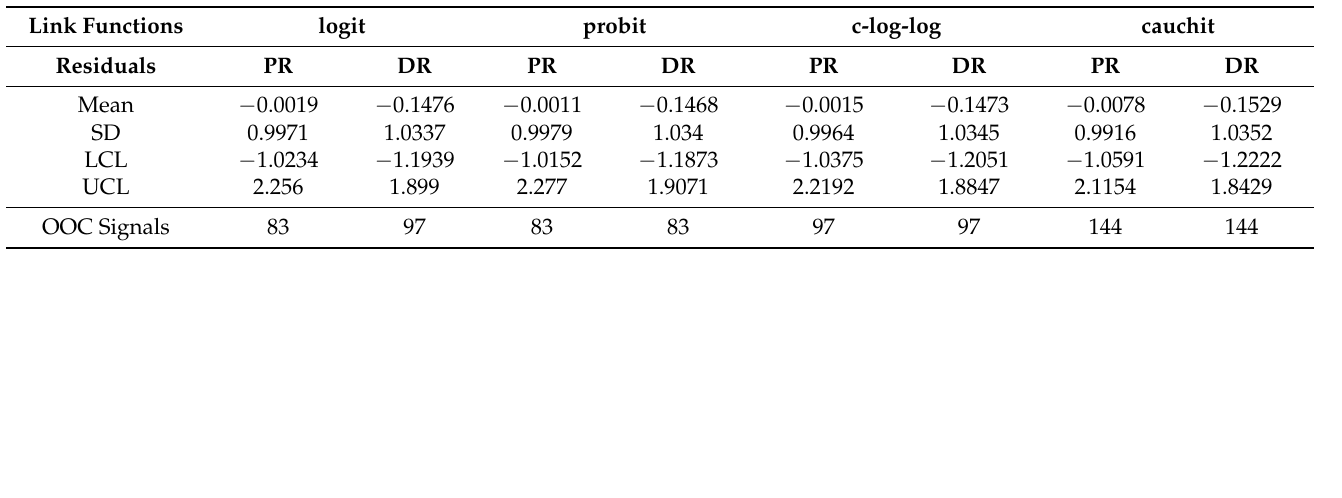
Table 6. For the COVID-19 data, the mean and standard deviation of logistic regression residuals, control limits and OOC signals under different link